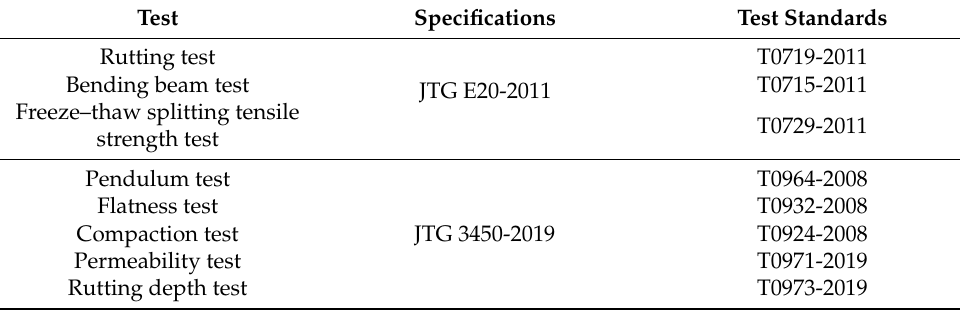
Table 3. Test standards for mixture and pavement performance